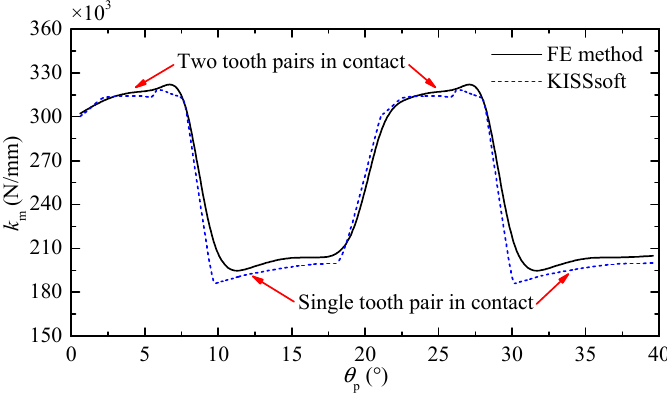
Figure 4. The friction curve of the DLC-coated sample. Figure 5. Validation of gear-mesh stiffness.